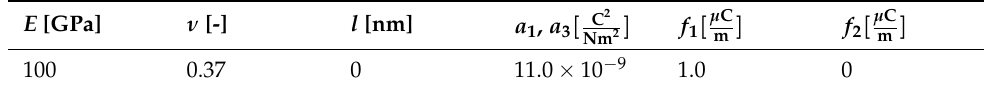
Table 4. Material properties for the truncated pyramid [16].